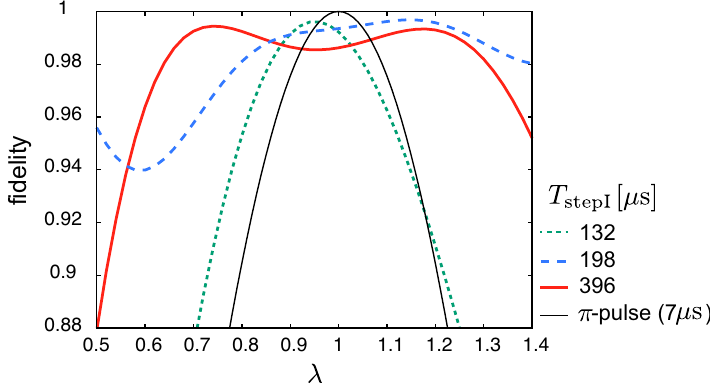
Figure 7. Dependence of the fidelity at t = T stepI on λ for the π -pulse and the invariant-based engineering protocols. λ is the multiplicative factor of amplitude error, where λ = 1 corresponds to no